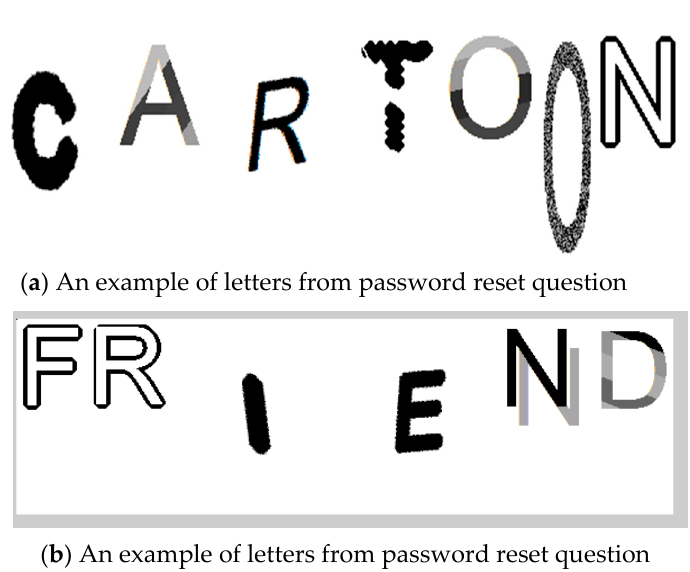
Figure 1. Part of password reset questions, changed to CAPTCHA letters.